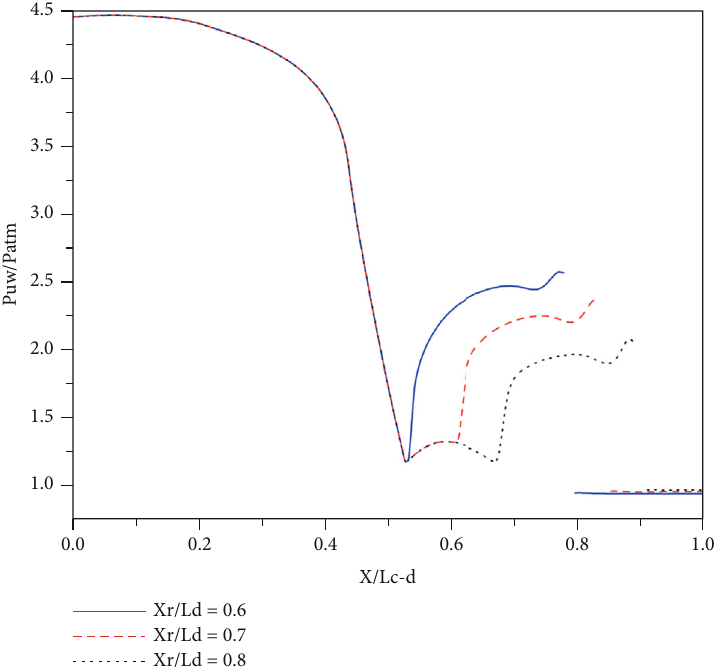
Figure 13: Static pressure distributions along the top wall for diverse rod locations ( NPR = 4 : 6 and H / R